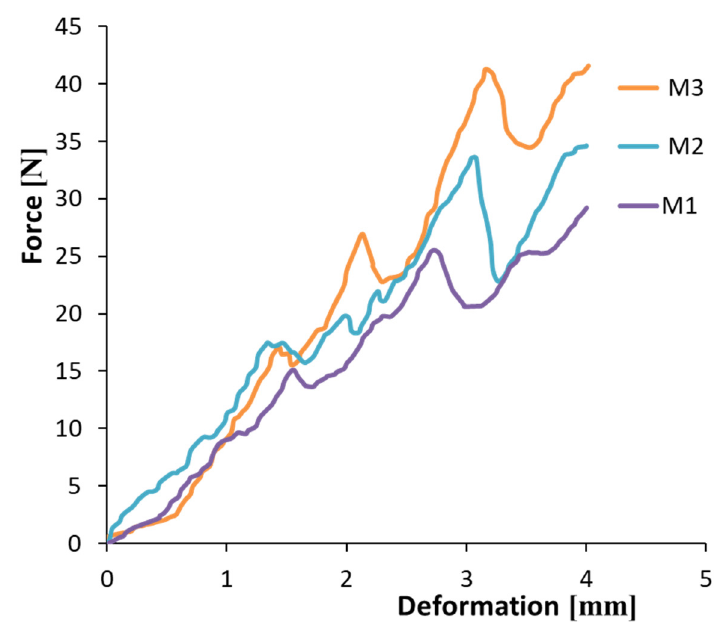
Figure 2. Force versus deformation curves of margarine samples.